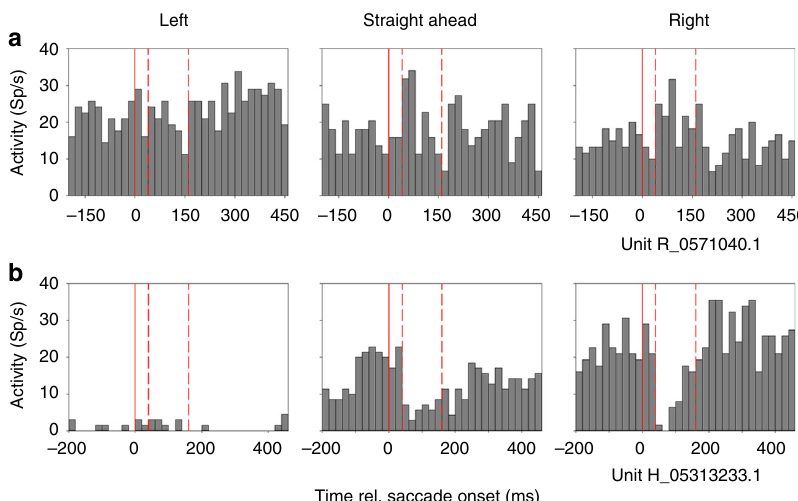
Fig. 5 Response modulation at the single-cell level. a The responses of the fi rst neuron revealed a signi fi cant tuning for leftward self-motion, as indicated by the pre- and post-saccadic activities (ANOVA on ranks, 2 df, P < 0.05). While there was a slight perisaccadic suppression of responses for leftward self- motion, perisaccadic responses were slightly enhanced for rightward motion. b This neuron revealed an opposite tuning, i.e., it was signi fi cantly tuned for rightward motion (ANOVA on ranks, 2 df, P < 0.05). In line with our hypothesis, this neuron revealed a strong saccadic suppression for rightward